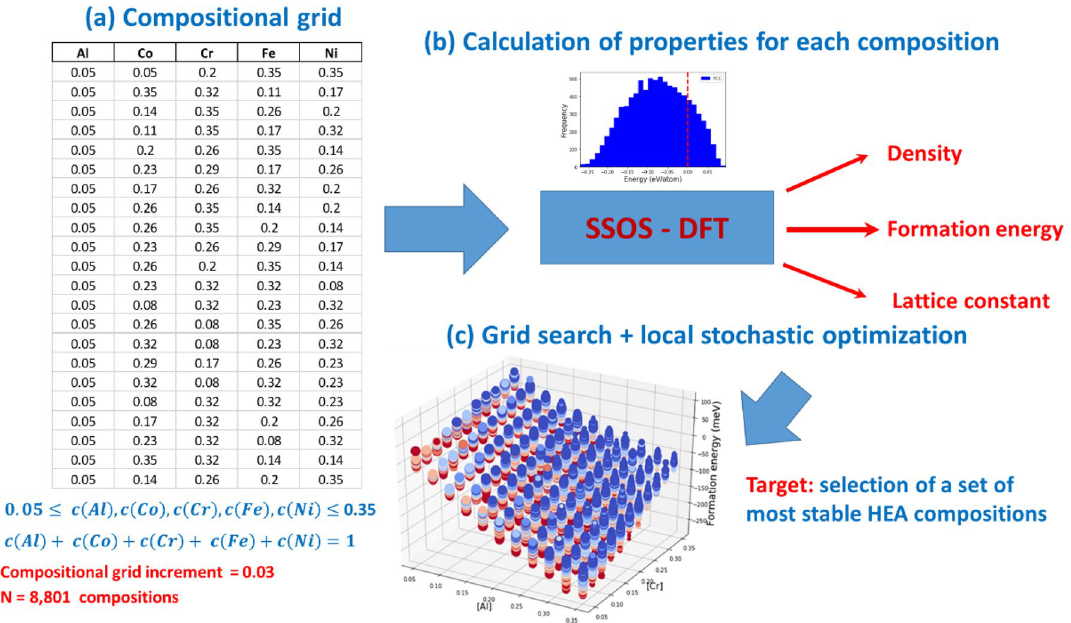
Figure 2. Schematic showing the compositional screening of a quinary HEA (AlCoCrFeNi) via the PSSOS method: ( a ) Construction of a compositional grid with a step size of 3% using N = 8801 compositions. Constraints on the molar fraction of constituent elements are indicated. ( b ) Calculations of the formation energy per atom, mass density and lattice constant for the constructed compositions of AlCoCrFeNi HEA with BCC and FCC lattices by the PSSOS method. ( c ) Selection of the most stable HEA compositions (with the lowest formation energies) for AlCoCrFeNi HEA, considering both BCC and FCC lattices.